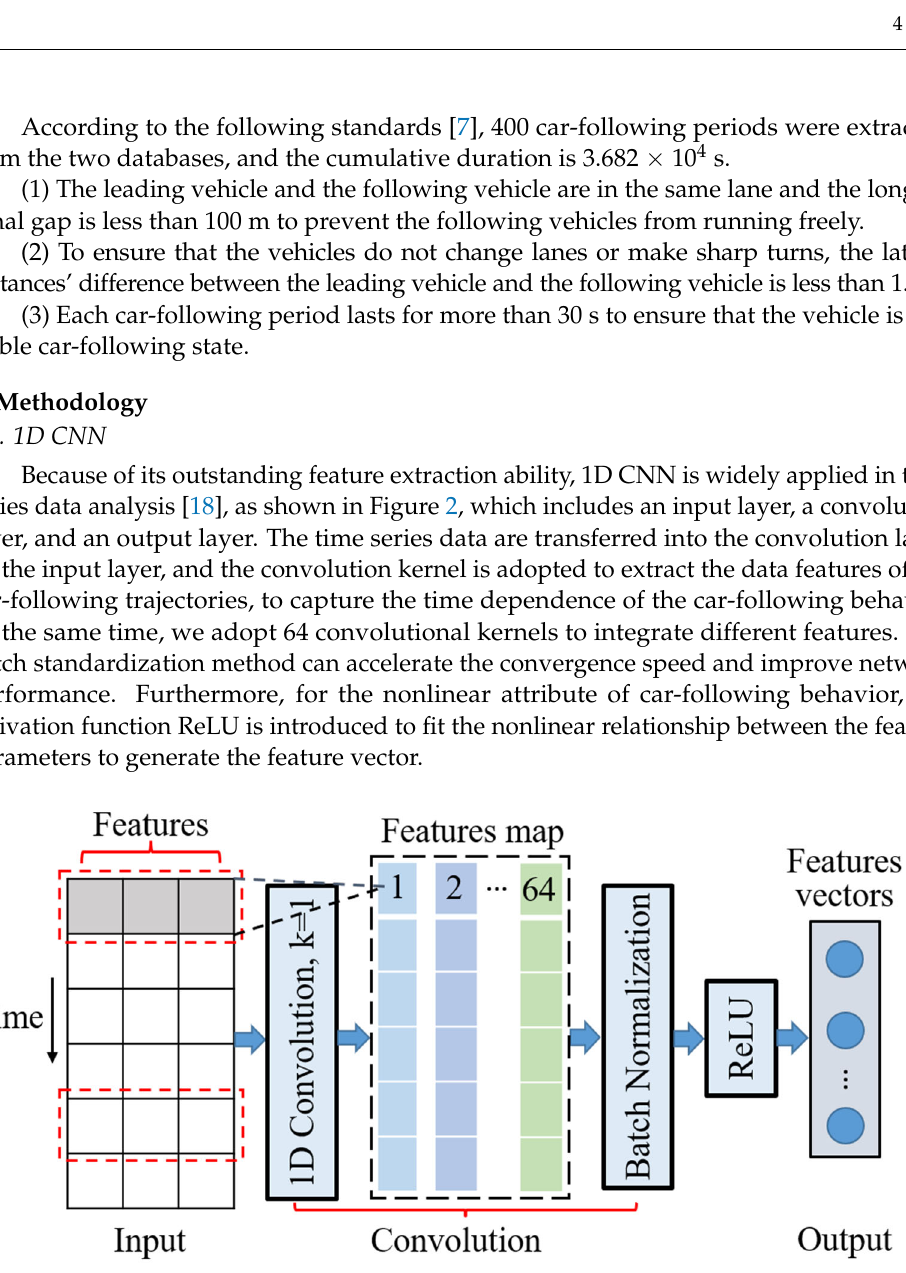
Figure 2. Feature extraction framework of 1D CNN.